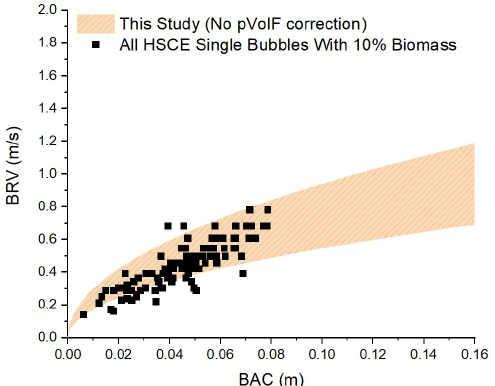
Figure 9. BRVs and BACs for single bubbles of all sizes, injected in the presence of 10 vol% biomass. Notes: (i) data points were obtained using the CREC-Optiprobes and the proposed HSCE model [19]; (ii) the probabilistic predictive model (PPM) bands are set as proposed in the present study.